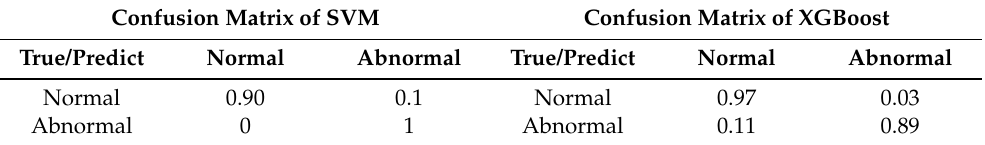
Table 1. Confusion matrix of SVM and XGBoost